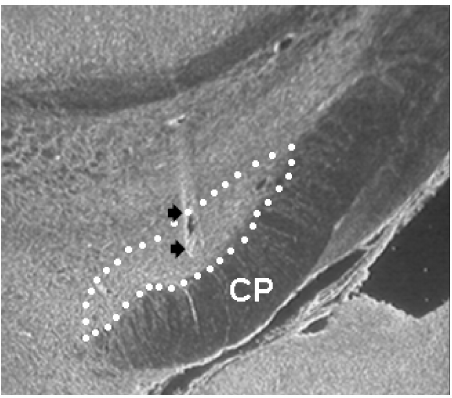
Figure 1. Photomicrograph illustrating the electrode place- ment in the STN. Subthalamic nucleus was outlined by the white dotted line. The black arrows show the location of the bared electrode tips delivering HFS in the STN. CP, cerebral peduncle.